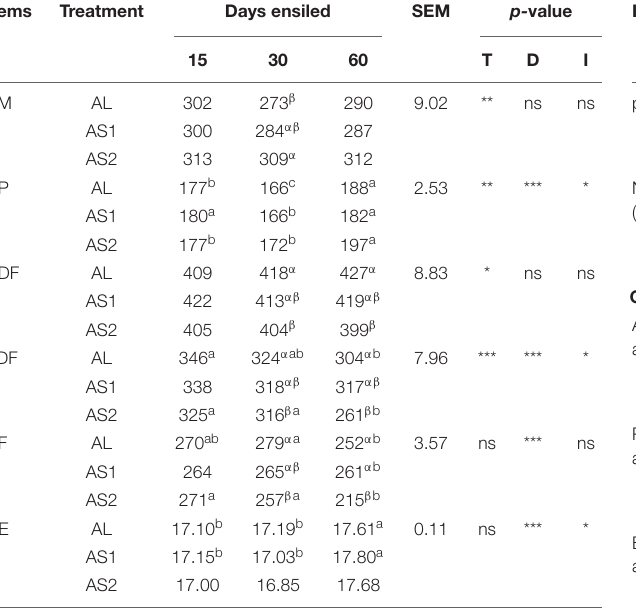
TABLE 2 | Chemical compositions of the alfalfa silages (g/kg DM). Items Treatment